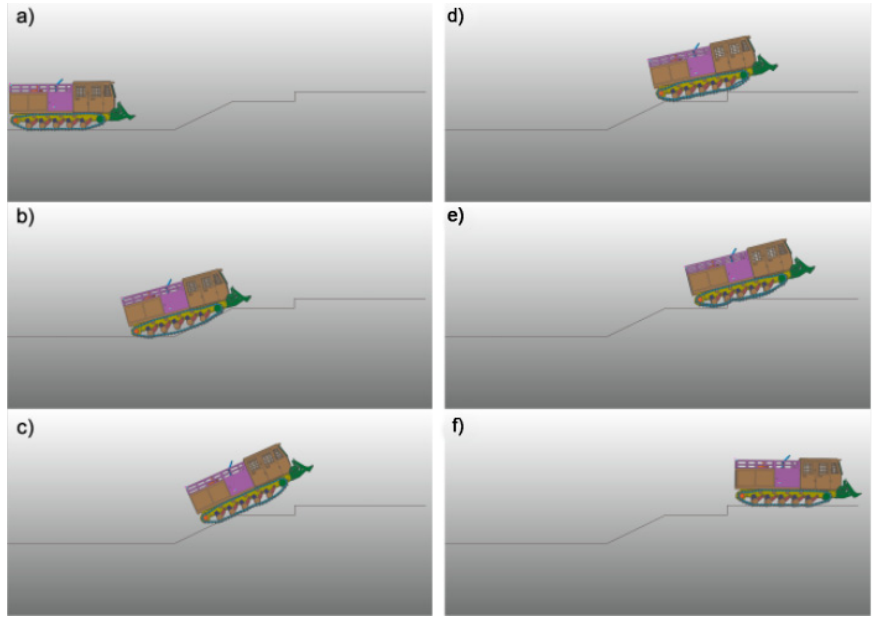
Figure 7. Virtual sample vehicle climbing over obstacles ( a – f ) are the process of vehicle driving).